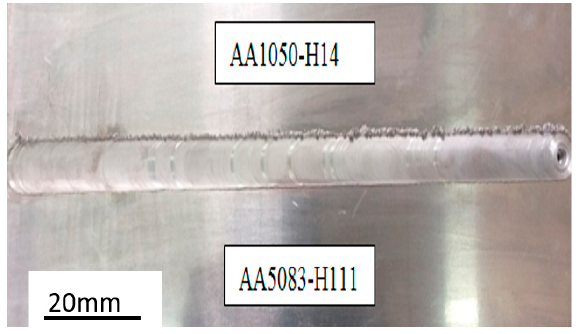
Figure 5. FSW joint. Table 2. Chemical composition of AA1050-H14 and AA5083-H111 (wt.%) [16,21,30].